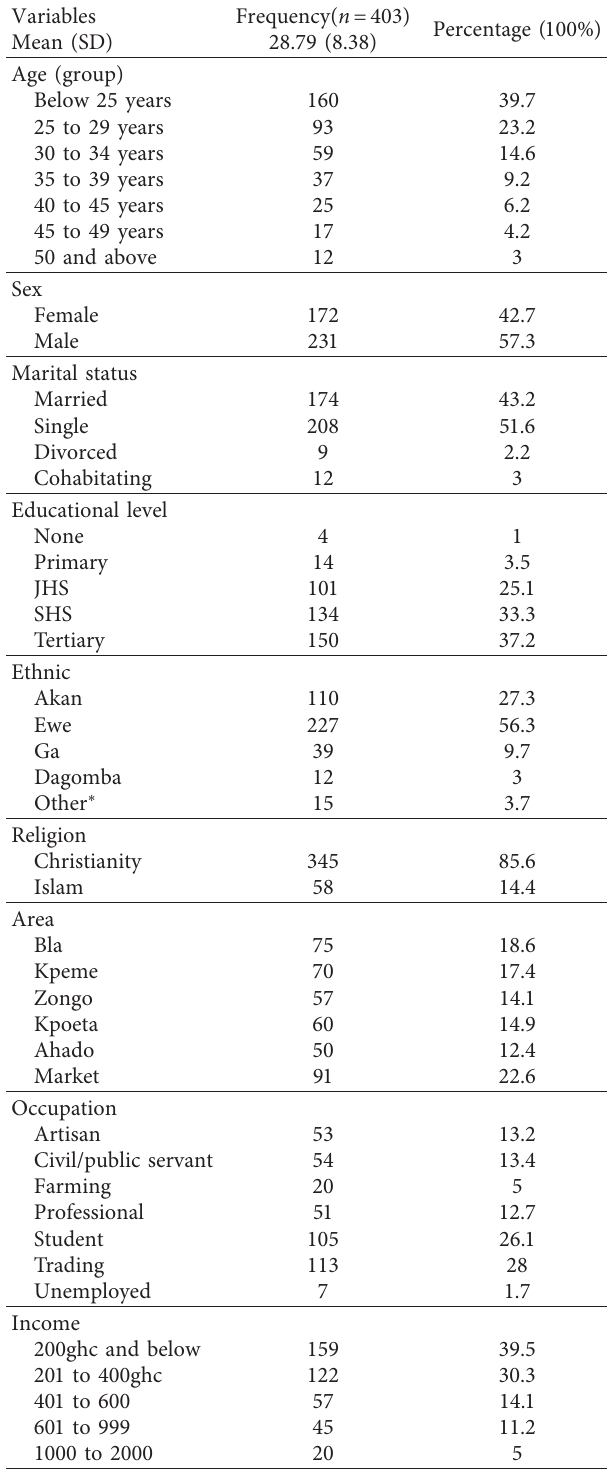
Table 1: Demographic characteristics of